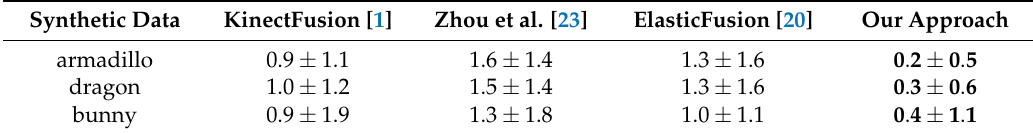
Table 3. Surface Reconstruction accuracy on our synthetic data, with C2M error metric ( Mean ± Std. ) in millimeters.